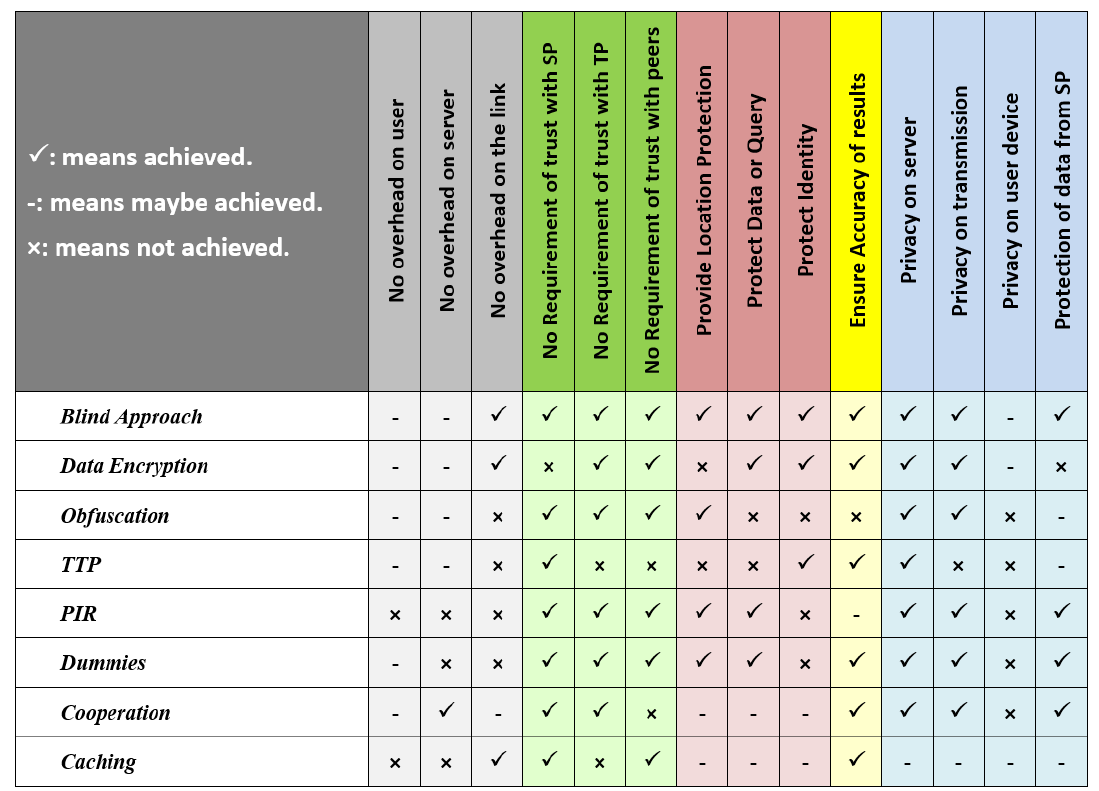
Figure 26. Performance of Blind Approach vs. Group of Seven